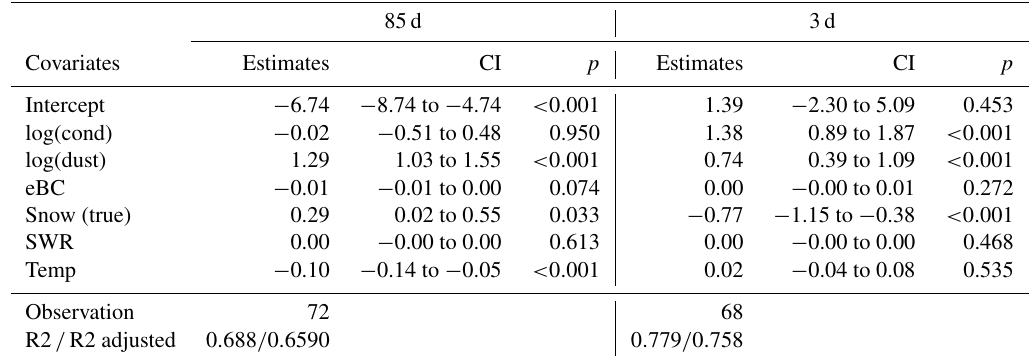
Table 1. Estimated coefficients, 95% confidence intervals and the corresponding p values for the covariates of the multiple linear regression model fitted to the 85 and the 3d experiments. The last rows of the table report the number of observations, the multiple coefficient of determination ( R 2 ) and its adjusted version. 85d